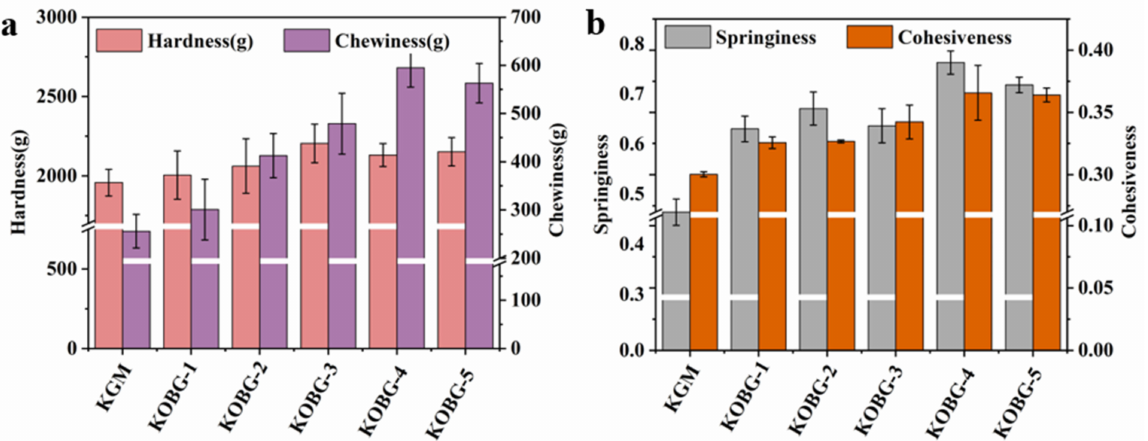
Figure 7. Hardness and chewiness of composite hydrogel on different oat β -glucan additions ( a ); springiness and cohesiveness of composite hydrogel on different oat β -glucan additions ( b